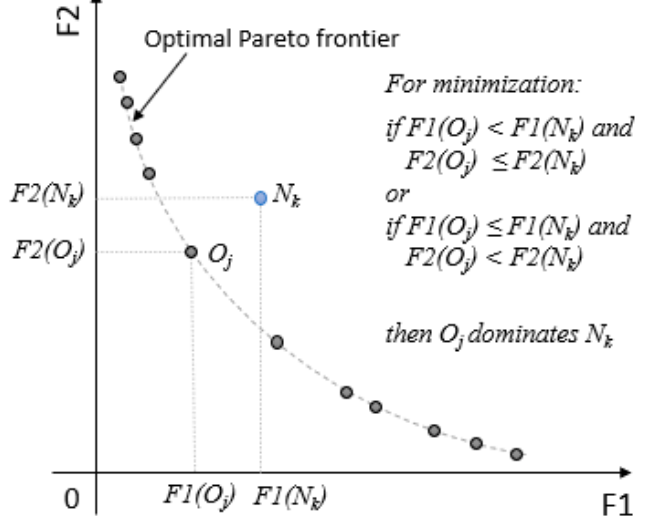
Figure 2. Non-dominated and dominated solutions in Pareto Figure 2. Non ‐ dominated and dominated solutions in Pareto frontiers.